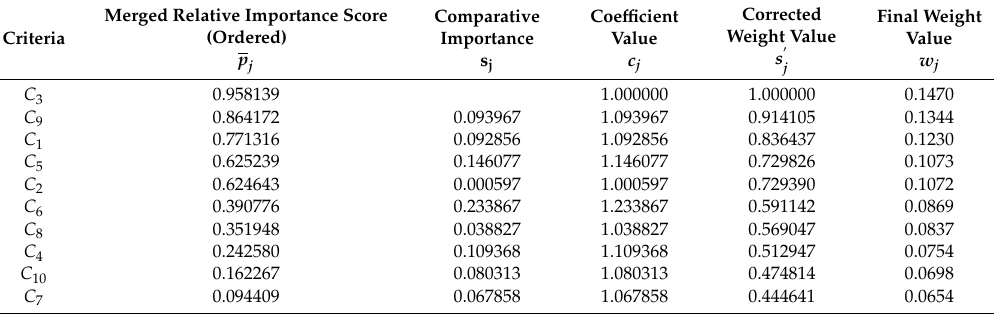
Table 3. Calculation of final criteria weights with the SWARA